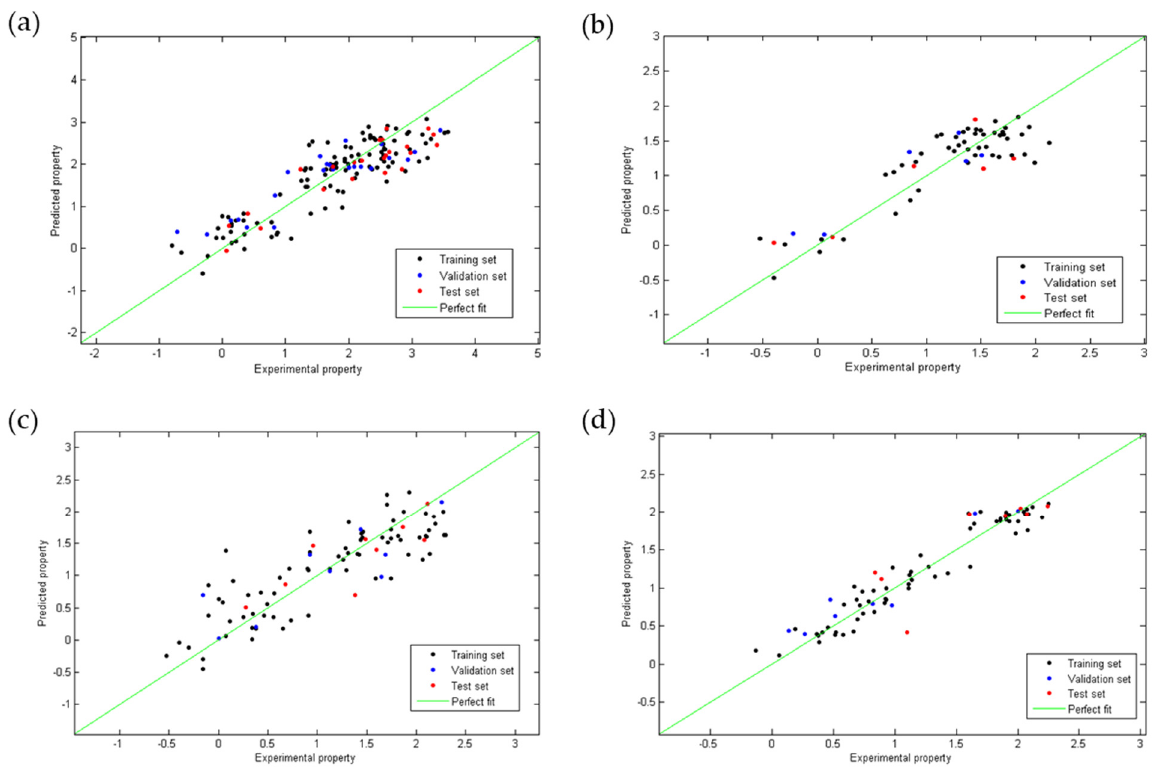
Figure 1. Linear correlation plots between the experimental and the predicted values obtained using the QSAR Equations (1) ( a ), (2) ( b ), (3) ( c ) and (4) ( d ).